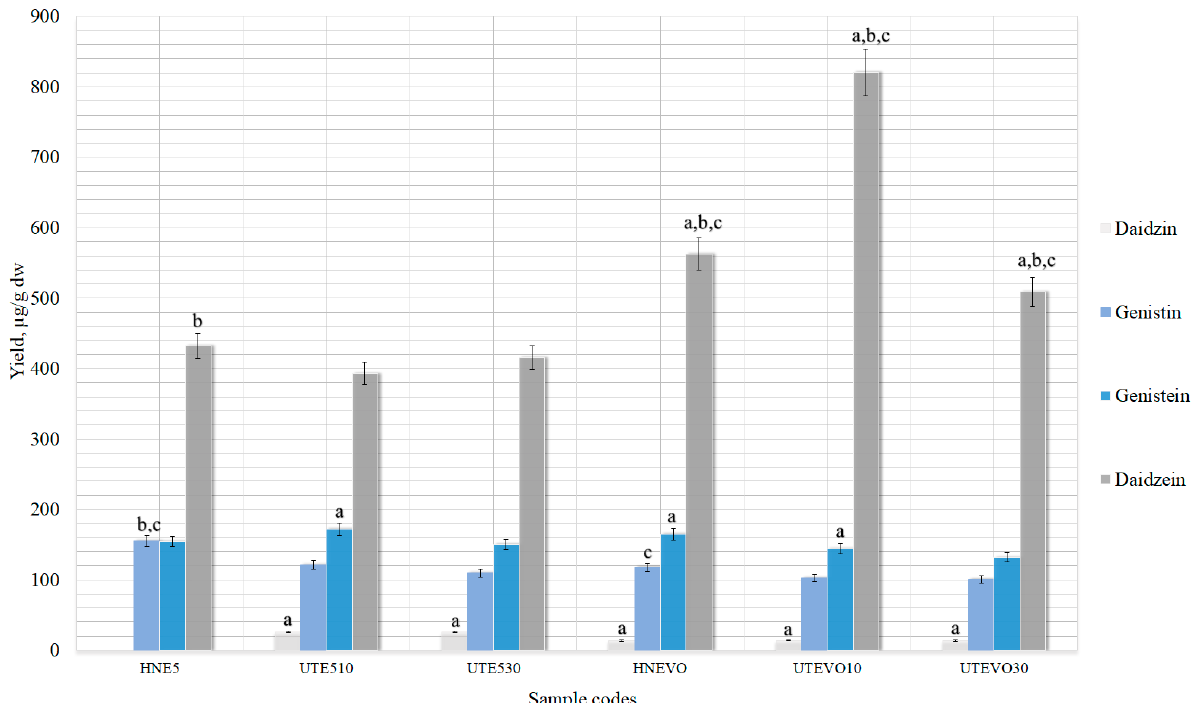
Figure 10. Quantitative yield of isoflavone aglycones using 1 of vinylpyrrolidone-vinyl acetate copolymer for extractions in 50% ethanol. Control samples without excipients (HNE5; UTE510; UTE530), 1% of excipient (HNEVO; UTEVO10; UTEVO30), a p < 0.05 vs. HNE5 sample; b p < 0.05 vs. UTE510, c p < 0.05 vs. UTE530. Sample codes and preparation conditions are displayed in Table 2.